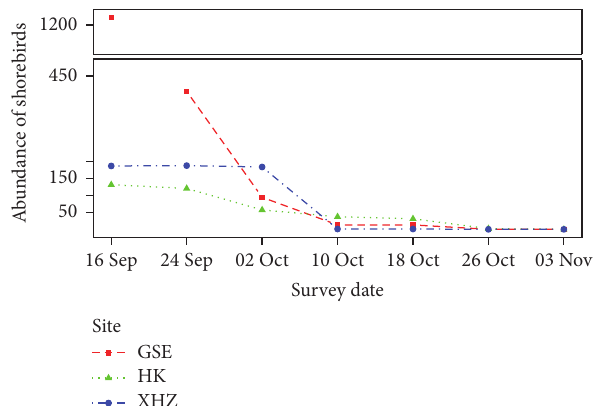
Figure 2: Number of shorebirds observed at the three sampling sites of Gesuer (GSE), Hekou (HK), and Xiaohaizi (XHZ) during the autumn migration.